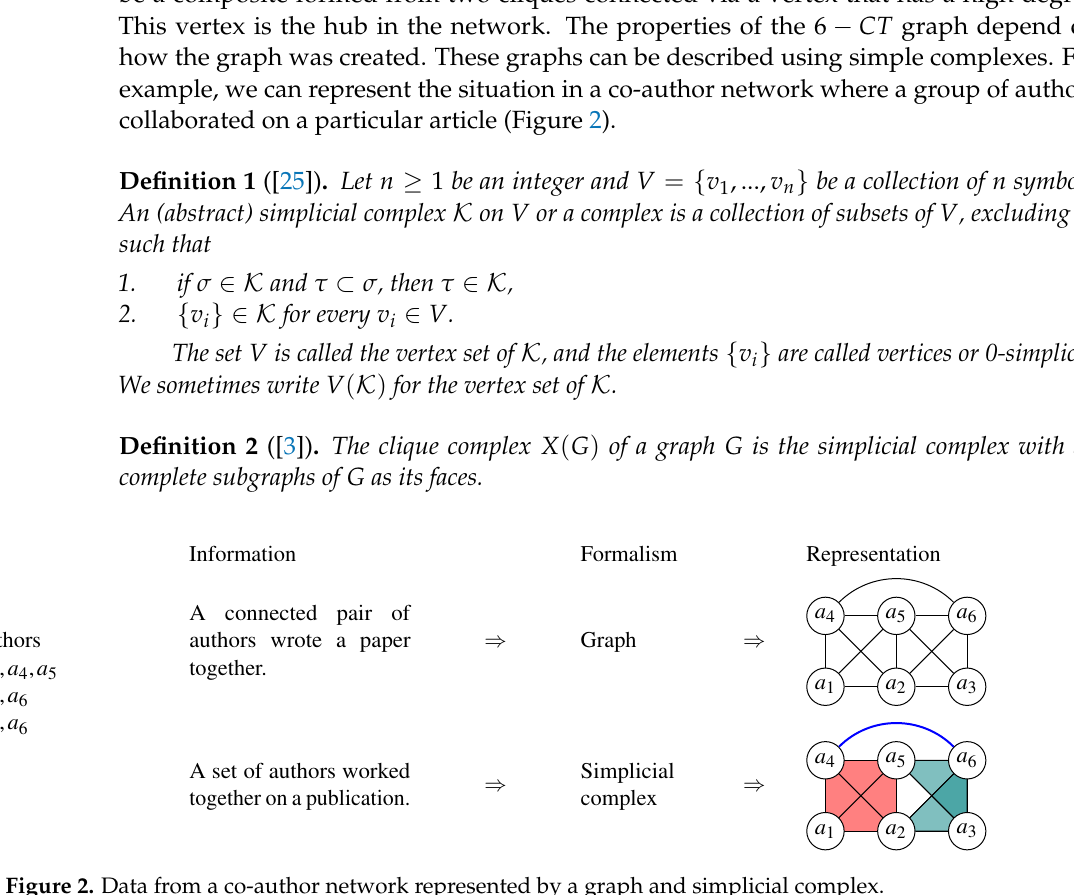
Figure 2. Data from a co-author network represented by a graph and simplicial complex.